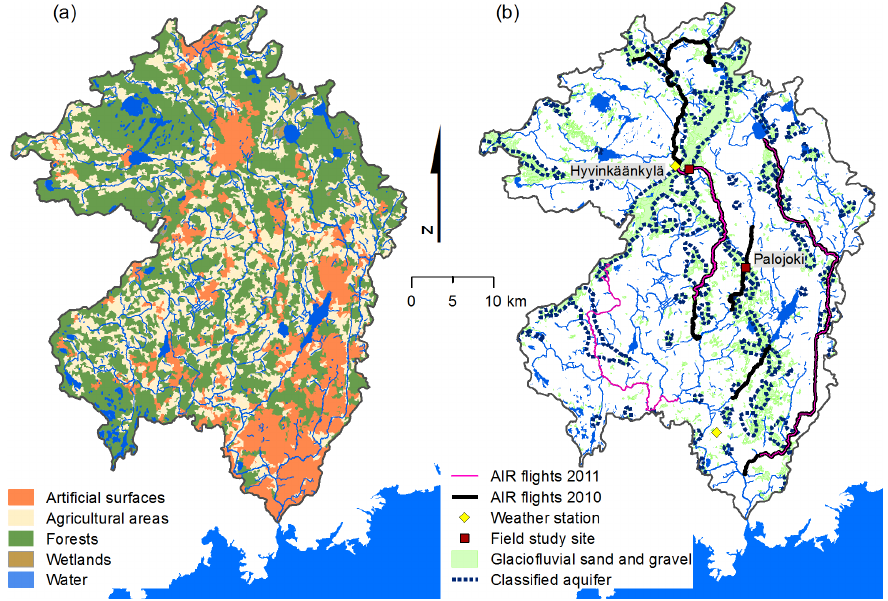
Figure 2. (a) Land use in the River Vantaa catchment. (b) Location of the classified aquifers of the River Vantaa catchment and AIR flights over the rivers Vantaa, Herajoki, Palojoki, Keravanjoki, Tuusulanjoki and Lepsämänjoki in 2010 and 2011. In Finland, mapped aquifers are classified into three classes according to their priority. (Corine land cover © National Land Survey of Finland 2010; Basemap Database © National Land Survey of Finland 2010; Quaternary Deposit Database © Geological Survey of Finland 2008; Groundwater Database © SYKE